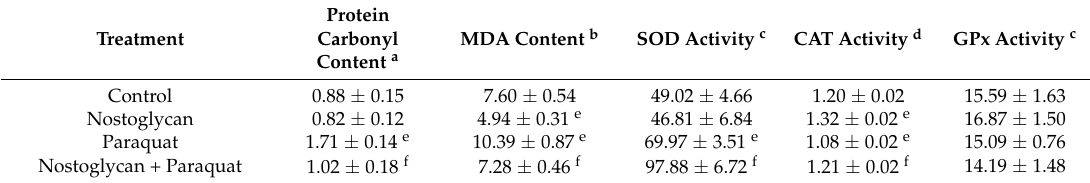
Table 1. Effect of nostoglycan on protein carbonyl and malondialdehyde contents and antioxidant enzyme activities in C. elegans